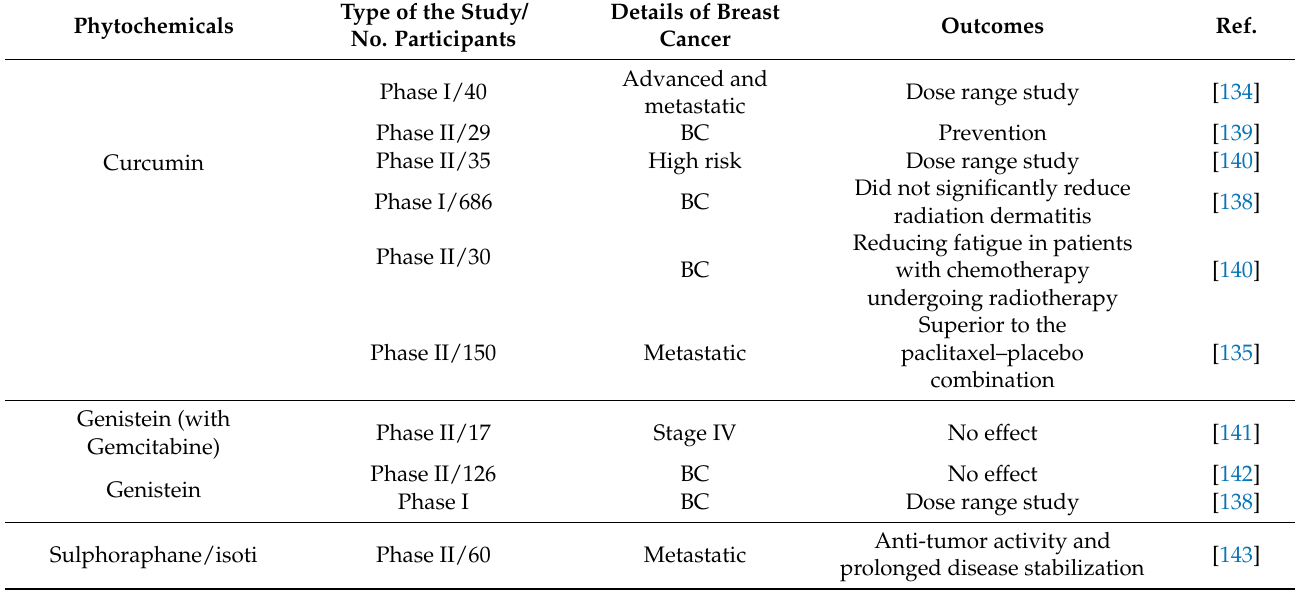
Table 2. Selected clinical trials evaluating the effect of some phytochemicals in breast cancer (BC) patients. Type of the Study/ Details of Breast Phytochemicals Outcomes No. Participants Cancer